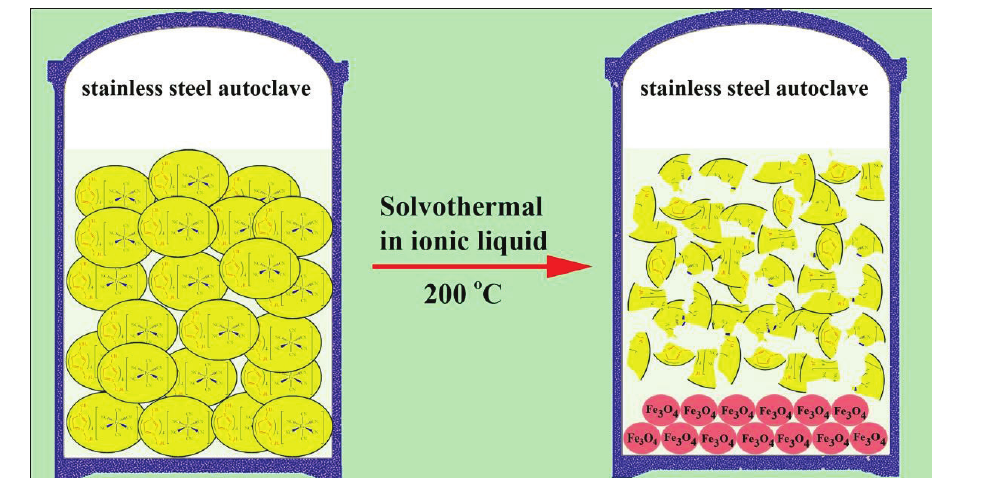
Fig. 2. Preparation of the magnetite nanoparticles in [BMIM][PF